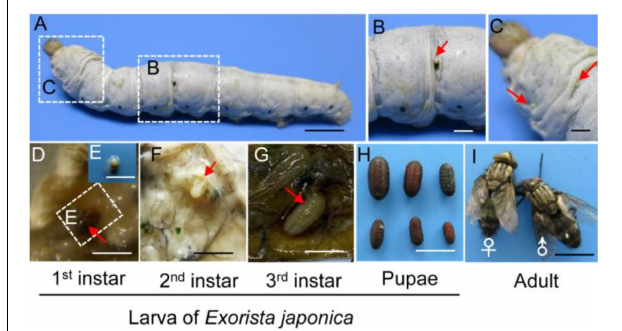
FIGURE 1 | The development stage of Exorista japonica . (A) E. japonica adults laid eggs on silkworm integument at the fifth larval stage. (B) A hatched egg indicated by a black-marked respiratory funnel at the point of egg laying (as shown by a red arrow). (C) Unhatched eggs without respiratory funnels (indicated by red arrows). (D,E) The first instar of E. japonica with a melanized sclerotized sheath around the posterior part of silkworm larval body. (F) The second instar of E . japonica attached to the respiratory funnel. (G) The third instar of E . japonica migrated freely in hemocele. (H) Pupae of E . japonica with different sizes. (I) Adults of E . japonica . Bars, 5 mm. Red arrows indicated the tachinid eggs or larva in (D–G)